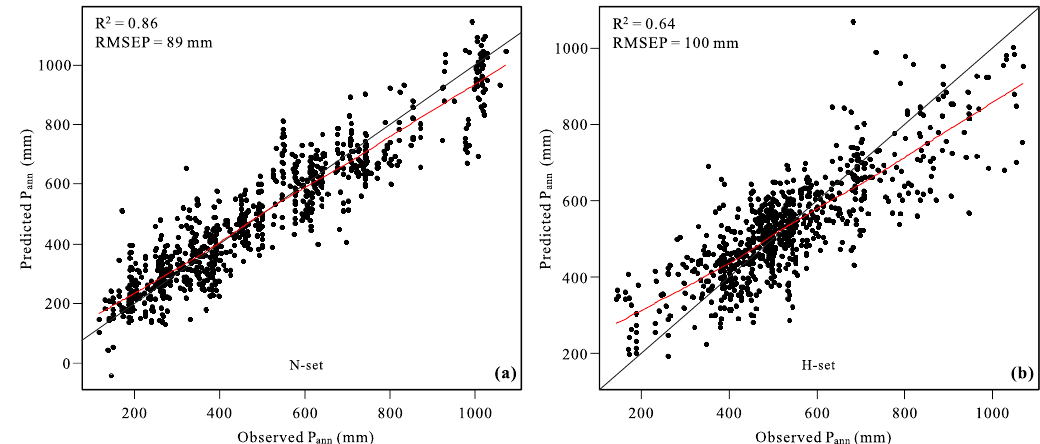
Figure 4. Scatter plots of pollen-based predicted annual precipitation ( P ann ) and observed P ann using two-component weighted averaging partial least squares (WA-PLS) models for (a) the natural set and (b) the human-induced set. Table 1. Summary statistics for redundancy analysis (RDA) with pollen species and climate variables (annual precipitation P ann , mean annual temperature T ann , mean temperature of the coldest month Mt co , mean temperature of the warmest month Mt wa ) and the human influence index (HII). Sole expl (%) is the pollen variance explained by variables as a sole predictor; marg expl (%) is the marginal contribution of this variable in the model with all other variables. All P values are 0.001 (based on 999 unrestricted Monte Carlo permutations). Variables Natural dataset Human-induced dataset λ 1 /λ 2 Sole expl (%) Marg expl